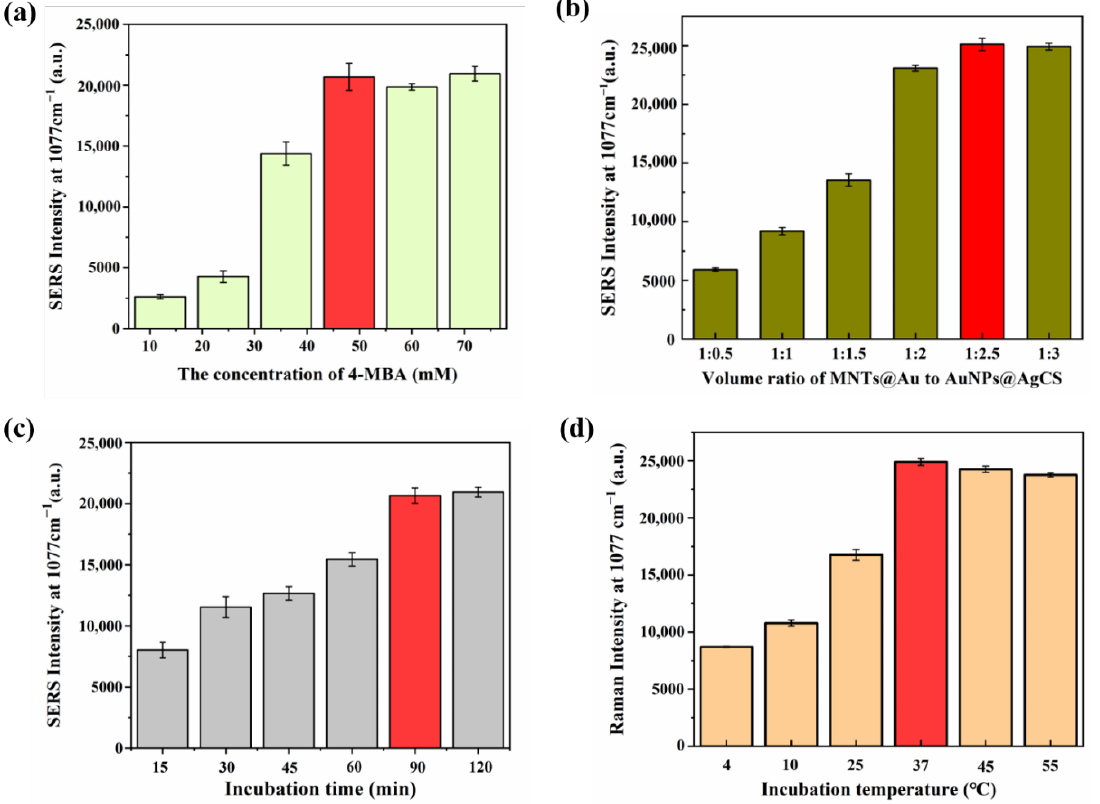
Figure 4. SERS intensity at 1077 cm − 1 for ( a ) various 4-MBA concentrations (10, 20, 30, 40, 50, 60, 70 mM); ( b ) ratios of different volumes of MNTs@AuNPs to Au@AgCS (1:0.5, 1:1, 1:1.5, 1:2, 1:2.5, 1:3); ( c ) various incubation periods (15, 30, 45, 60, 90, 120 min); and ( d ) different incubation temperatures. The standard deviation of the repeated experiments is indicated by the error bars.